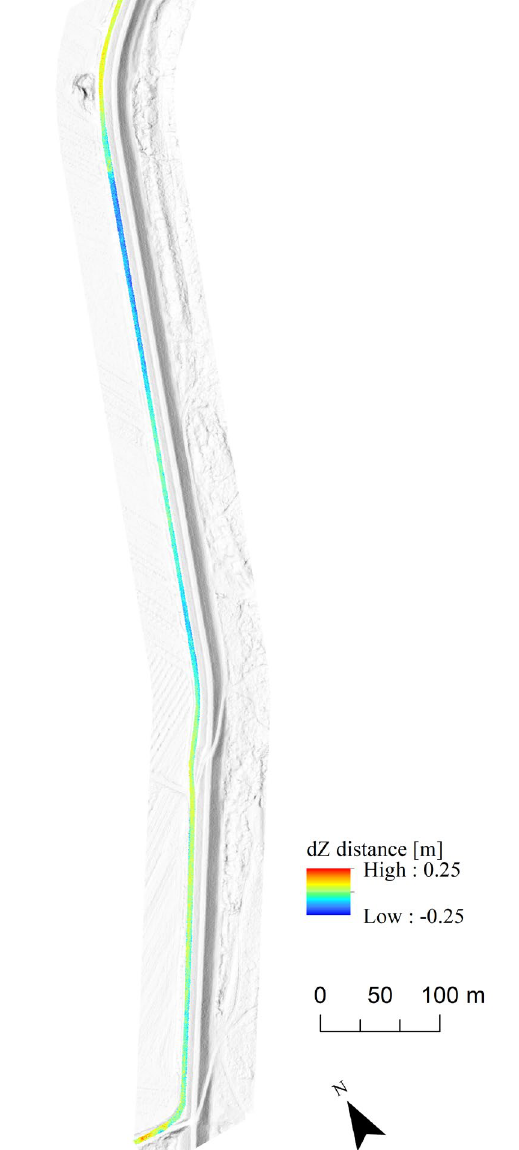
Fig. 4. Visualisation of height differences between the oriented ULS and DIM point clouds overlaying the hillshade model of Tarnobrzeg test